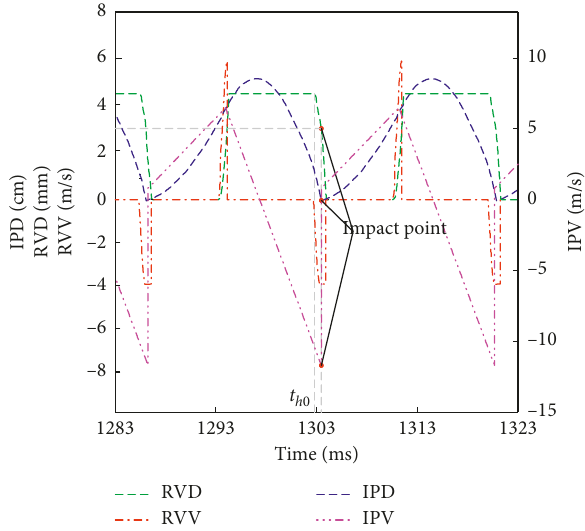
Figure 5: The simulation curves of displacement and velocity of the reversing valve and impact piston. IPD: impact piston displace- ment; IPV: impact piston velocity; RVD: reversing valve dis- placement; RVV: reversing valve velocity.